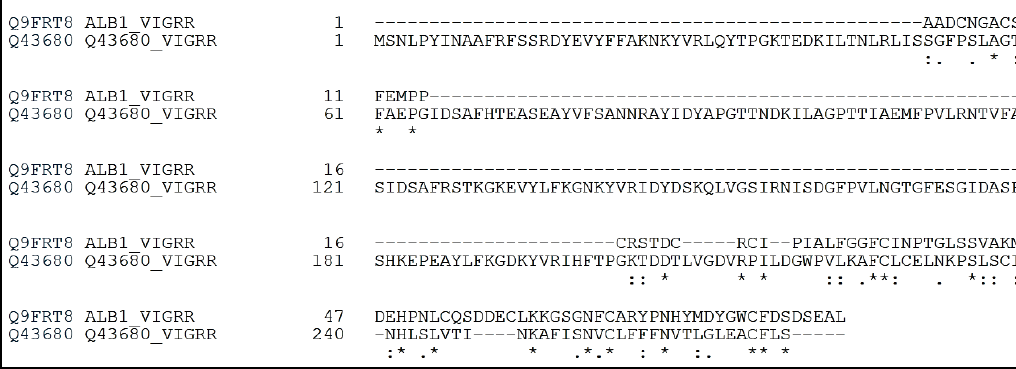
Figure 1. Alignment of the mung bean albumin sequences currently present in the UniProt Database. The alignment was conducted using Clustal Omega. Q9FRT8 is the reviewed sequence of a 10 kDa protein fragment, while Q43680 is the non-reviewed sequence of a 30 kDa protein. The sequences have 7% identity, with 19 identical positions and 21 similar positions. Asterisks (*) indicate identical amino acids in the sequences, while dots indicate amino acids in the sequences that are not identical.